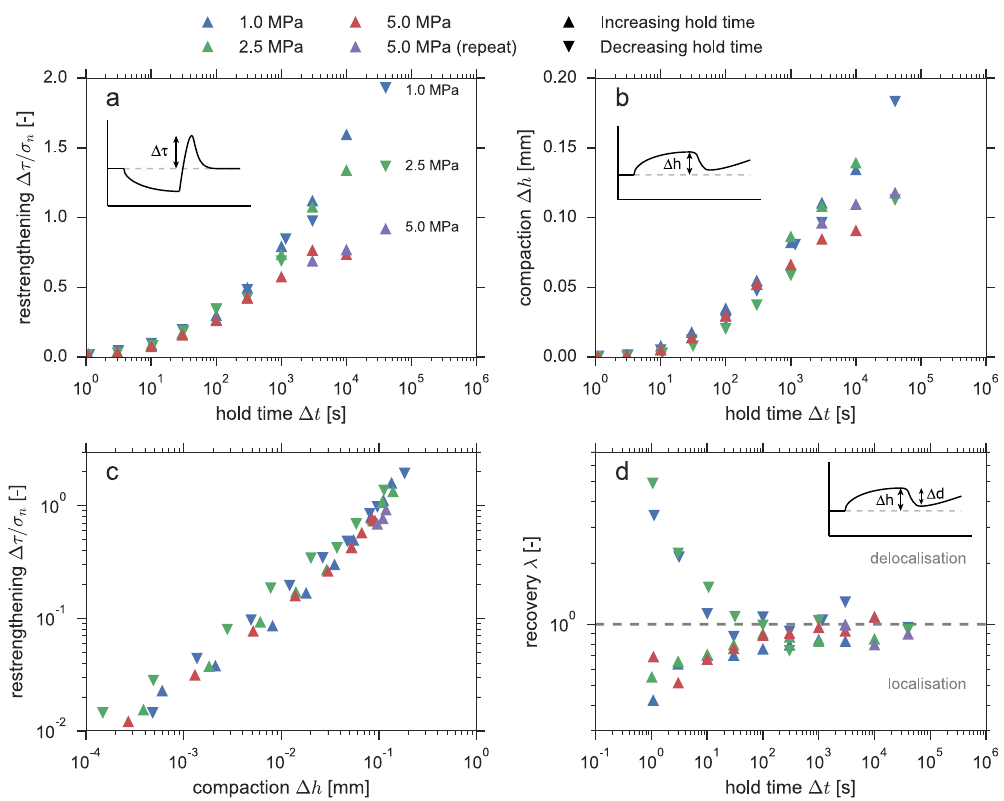
Figure 2. Overview of the mechanical response of the laboratory samples. ( a ) Frictional restrengthening, expressed as an apparent coefficient of friction Δ μ ′ = Δ τ / σ n , as a function of hold duration; ( b ) Sample compaction during the hold as a function of hold duration; ( c ) Frictional restrengthening as a function of the compaction attained during the hold; ( d ) Volumetric strain recovery during resliding, λ = Δ d / Δ h , with values < 1 suggesting localised deformation, and values > 1 suggesting delocalisation. Values of σ n , and the direction of the slide-hold-slide sequence (increasing or decreasing hold steps) are as indicated in the